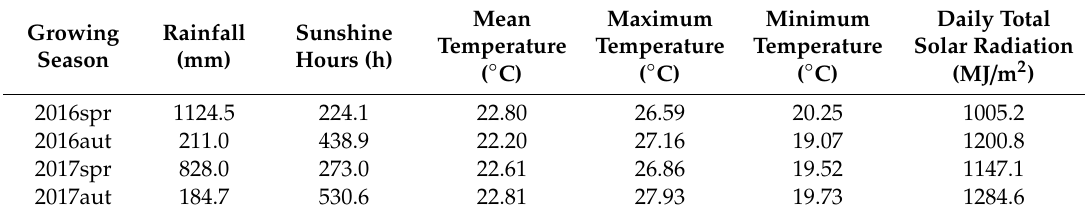
Table 1. Seasonal variations in external environmental conditions during the growth period of sweet corn.